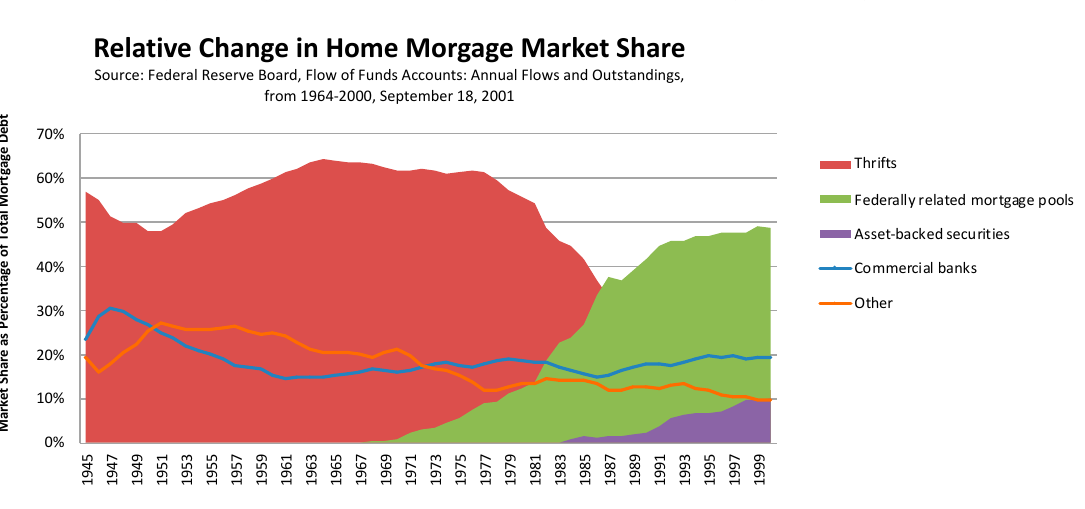
Figure 2. Changes in “Thrift Market Share”, which uses data from the Federal Reserve Board, Flow of Funds Accounts: Annual Flows and Outstanding’s.